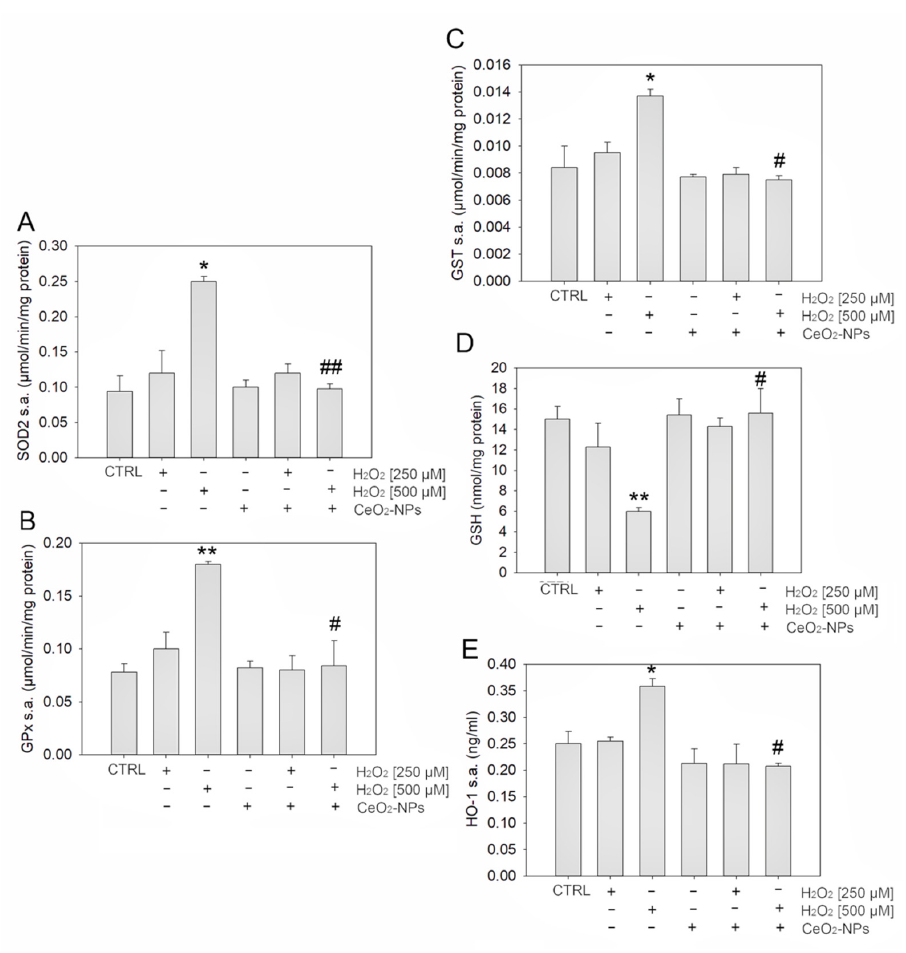
Figure 4. Antioxidant effects of CeO 2 -NPs on ARPE-19 cells treated with H 2 O 2 . The graphs show the enzyme specific activity of SOD 2 ( A ), GPx ( B ), and GST ( C ), as well as GSH ( D ) and HO-1 ( E ) levels. Histograms indicate the means ±SE of three different cultures each of which was tested in triplicate. Statistical analysis was performed by one-way ANOVA followed by Tukey’s test. * p < 0.05, ** p < 0.01 vs. CTRL, and # p < 0.05, ## p <0.01 vs. H 2 O 2 .